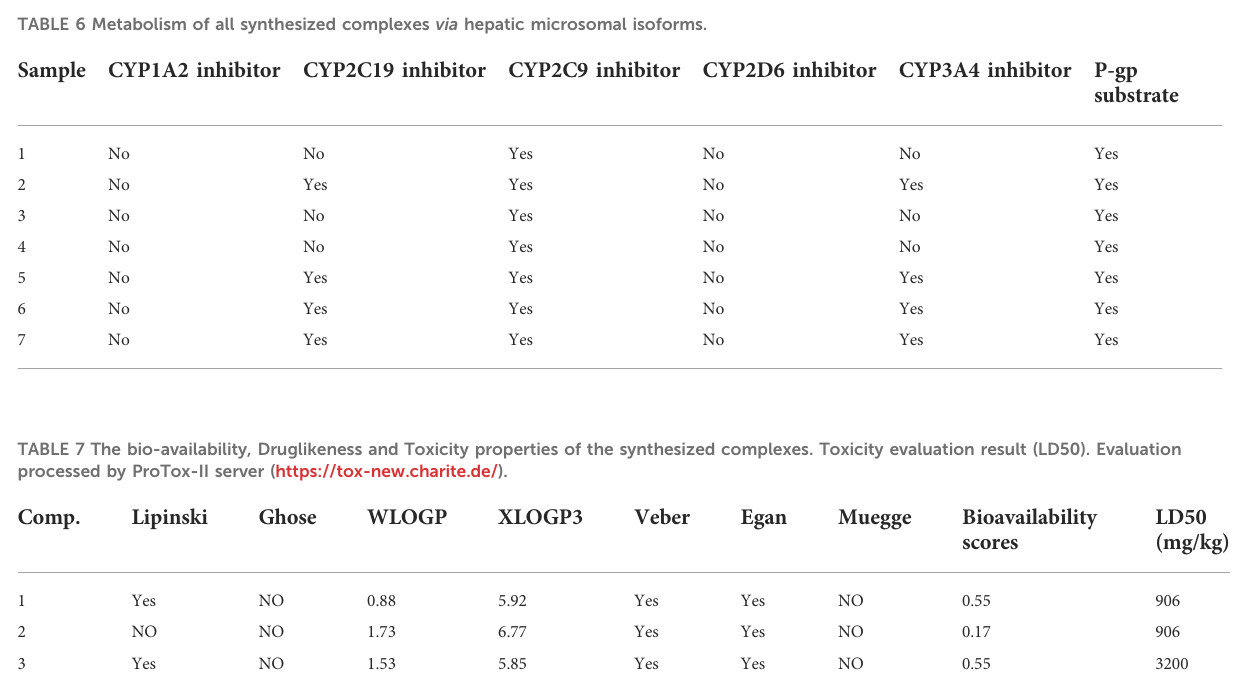
TABLE 6 Metabolism of all synthesized complexes via hepatic microsomal isoforms.